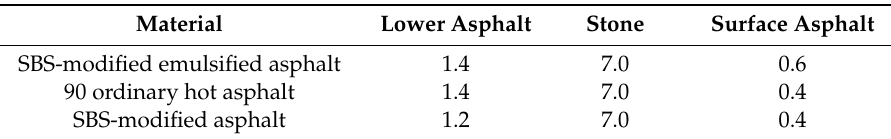
Table 7. Waterproof cohesive layer material quantity (kg / m 2 ).